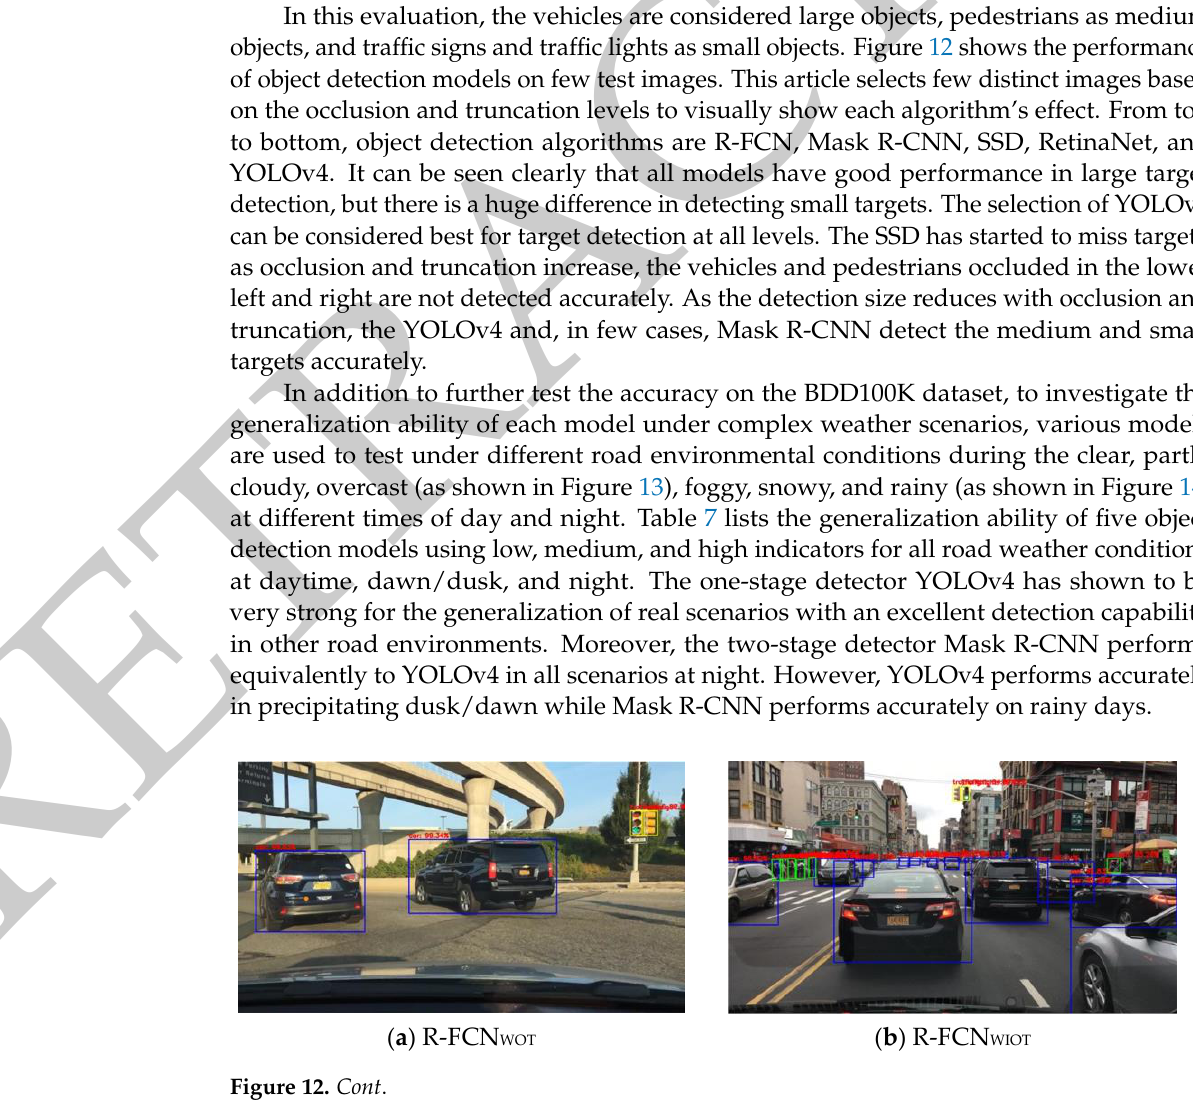
Table 6. The computation time of object detection models on the BDD100K dataset. Model